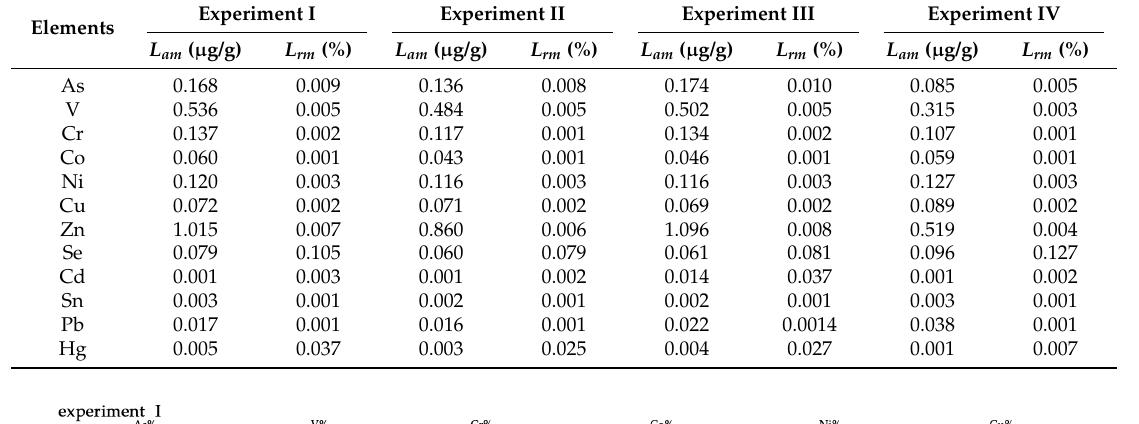
Table 9. The maximum leached amount ( L am ) and leachability ( L rm ) of metals from coal gangue in the Wulantuga open-cast coal mine area.